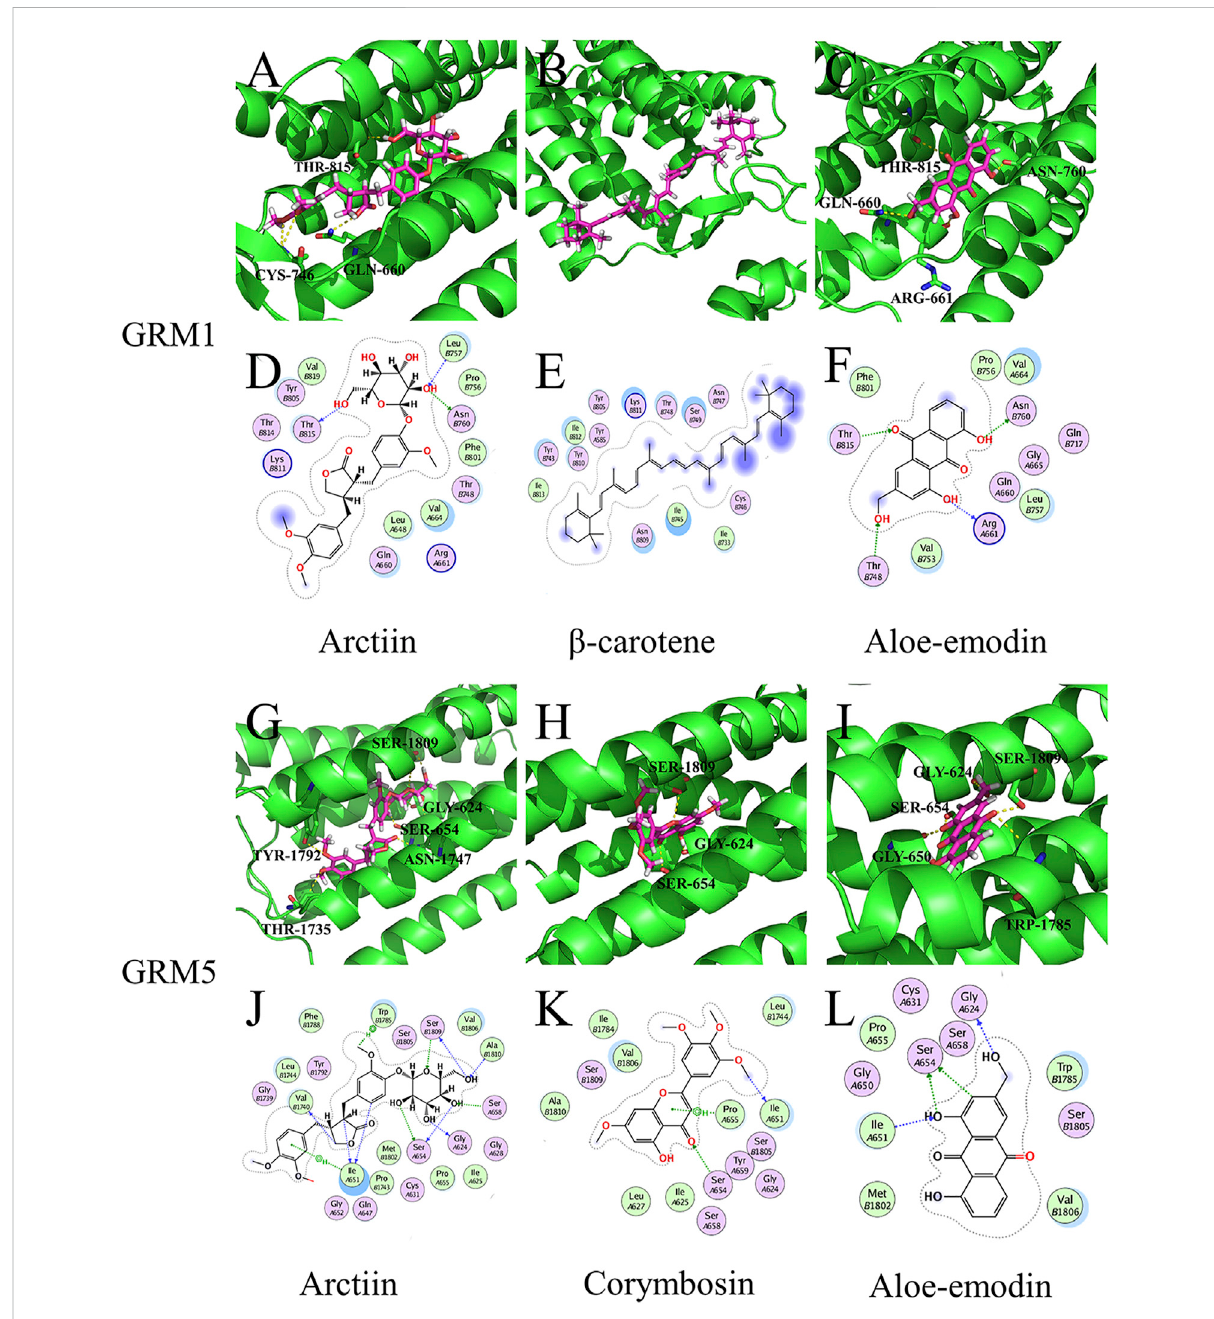
FIGURE 5 Molecular models of active compounds with speci fi c key LHQW target genes. (A) Molecular model of arctiin, (B) β -carotene, (C) and aloe- emodin binding to GRM1. (G) Molecular model of arctiin, (H) corymbosin, (I) and aloe-emodin binding to GRM5. Yellow dashed lines represent H-bonds, thick pink sticks represent the active compounds, and thick green sticks represent residues in the protein-binding site. (D) Interactions between arctiin, (E) β -carotene, (F) aloe-emodin, and GRM1. (J) Interaction between arctiin, (K) corymbosin, (L) aloe-emodin, and GRM5. Blue dashed lines represent H-bonds between the active compounds and residue backbones, and green dashed lines represent H-bonds between the active compounds and residue sidechains. The dashed lines point to the